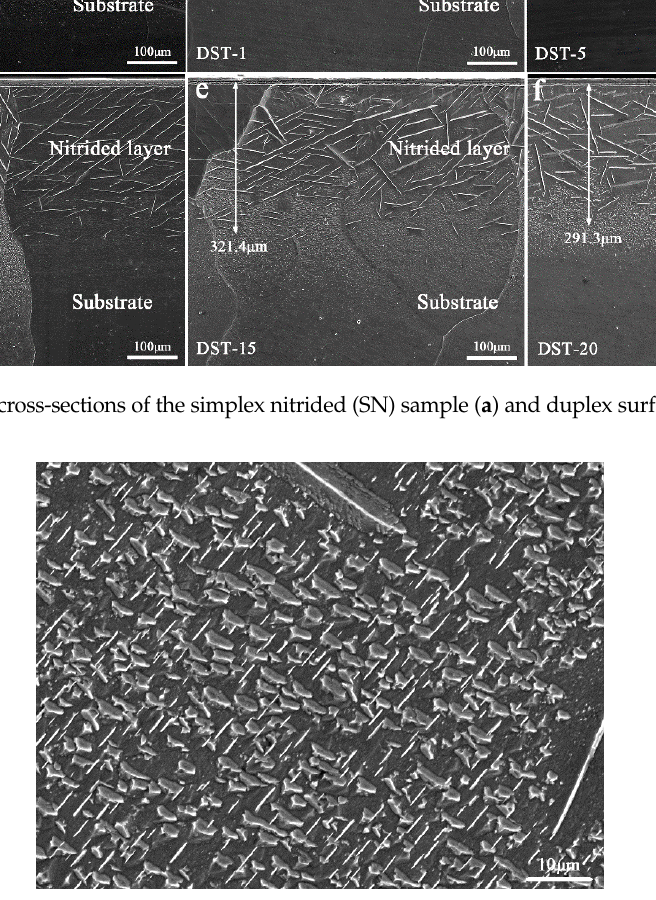
Figure 4. High magnification morphology of the box A area in Figure 3a.